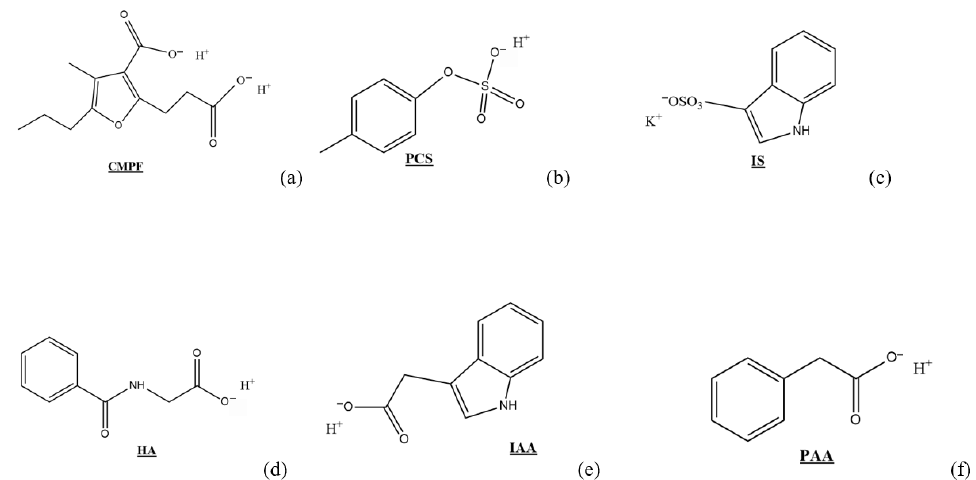
Figure 1. Chemical structure and charge location for ( a ) 3 − carboxyl − 4 − methyl − 5 − propyl − 2 − furan propanoic acid (CMPF), ( b ) p − cresyl sulfate (PCS), ( c ) indoxyl sulfate (IS), ( d ) hippuric acid (HA), ( e ) indole −3− acetic acid (IAA), and ( f ) phenylacetic acid (PAA). Table 1. Physical properties of protein-bound uremic toxins, significance in CKD patients, and major co-morbidities caused by the accumulation in the blood compartment.